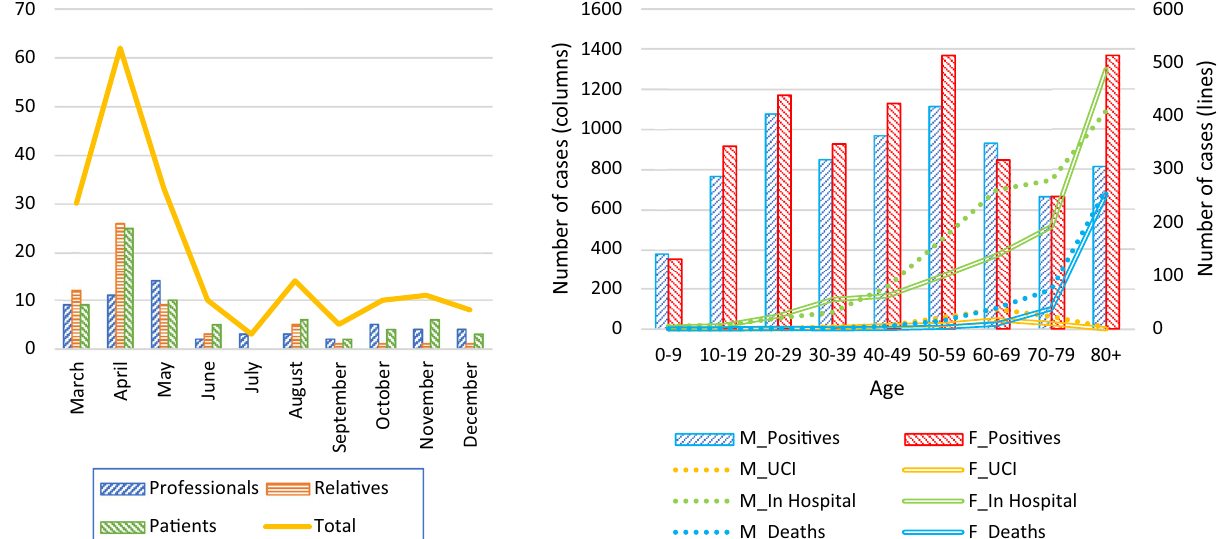
Figure 3. Left: PASMICOR demand evolution by months. Right: Number of hospitalizations, ICU admissions and deaths by sex and age in the province of Salamanca. From 19 March to 30 November. Data obtained from the Ministry of Health 2 . Positives: Number of reported cases confirmed with an active infection diagnostic test (AIDT) as established in the COVID-19 Early Detection, Surveillance and Control Strategy. In Hospital: Number of hospitalised cases. ICU Number of cases admitted to the ICU. Deaths: Number of deaths. (M: male, F: